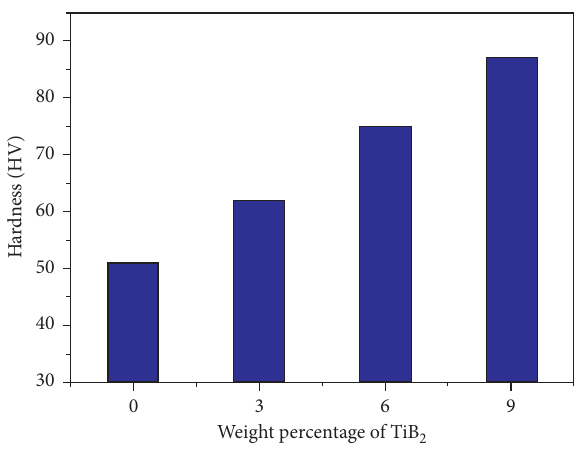
Figure 5: Impact of hardness on the wt% of TiB